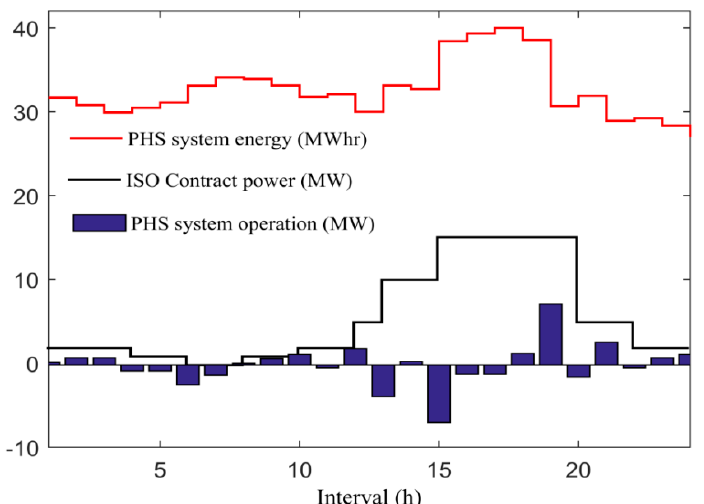
Figure 12. Pumped hydroelectric storage system operation.